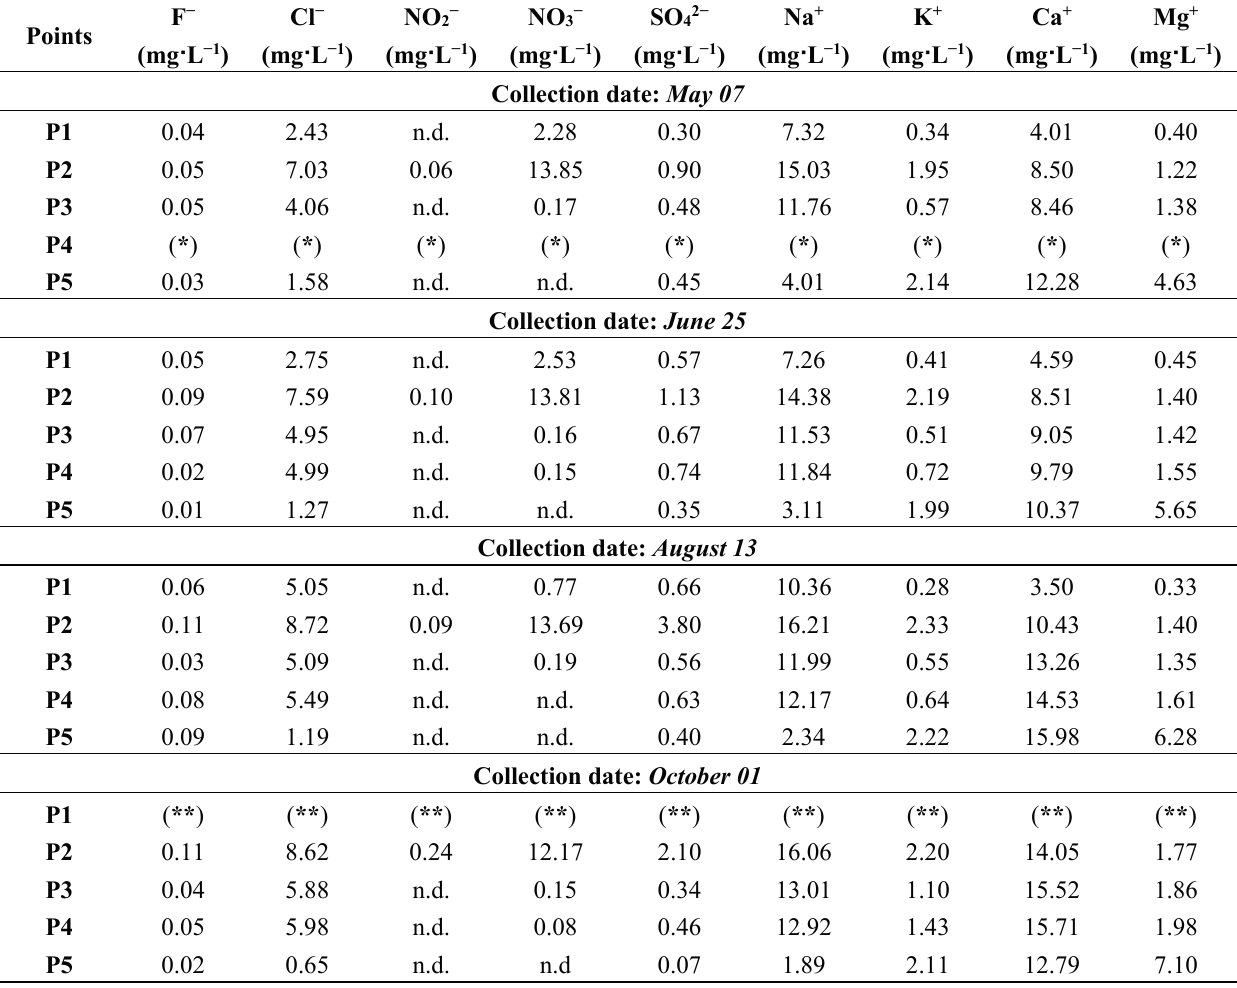
Table 2. Result of the concentrations of ions analyzed in the surface water at the headwaters of the Preto River, Formosa,